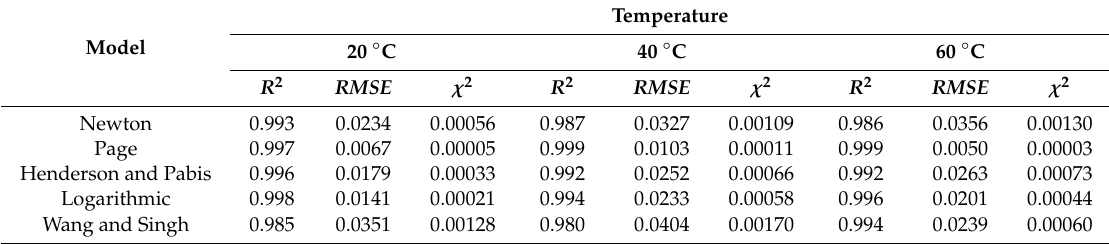
Table 3. Statistical analysis of modelsdescribing the kinetics of vacuum drying of Moldavian dragonhead.